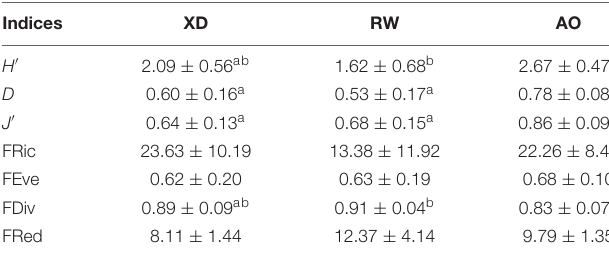
TABLE 3 | Species and functional diversity indices in three intertidal communities.